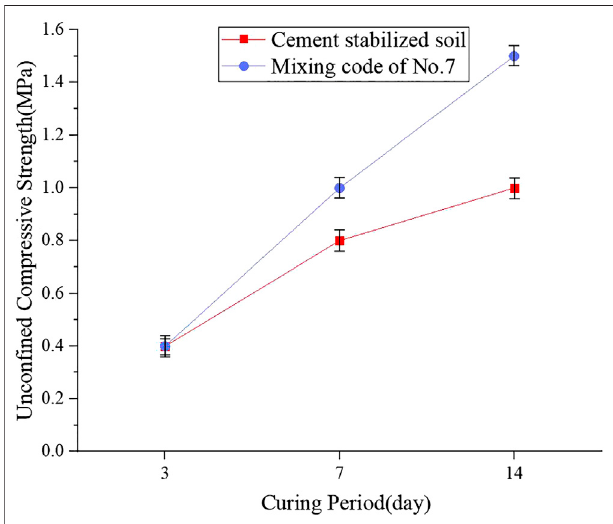
FIGURE 7 | UCS of soil stabilized by cement and mix #7 geopolymers.